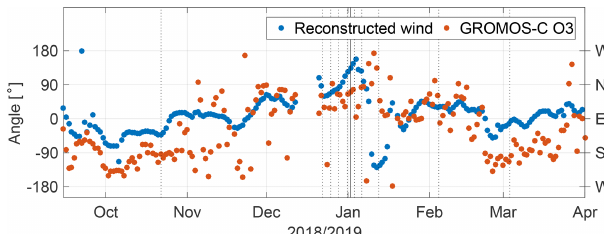
Figure 13. Direction of the horizontal wind field at Ny-Ålesund reconstructed from the stationary planetary waves 1 and 2 and the background wind, and the angle of the GROMOS-C ozone gradi- ents at 3hPa. The dotted lines indicate the dates of the polar vortex snapshots in Fig. 6 and the solid line shows the central date of the